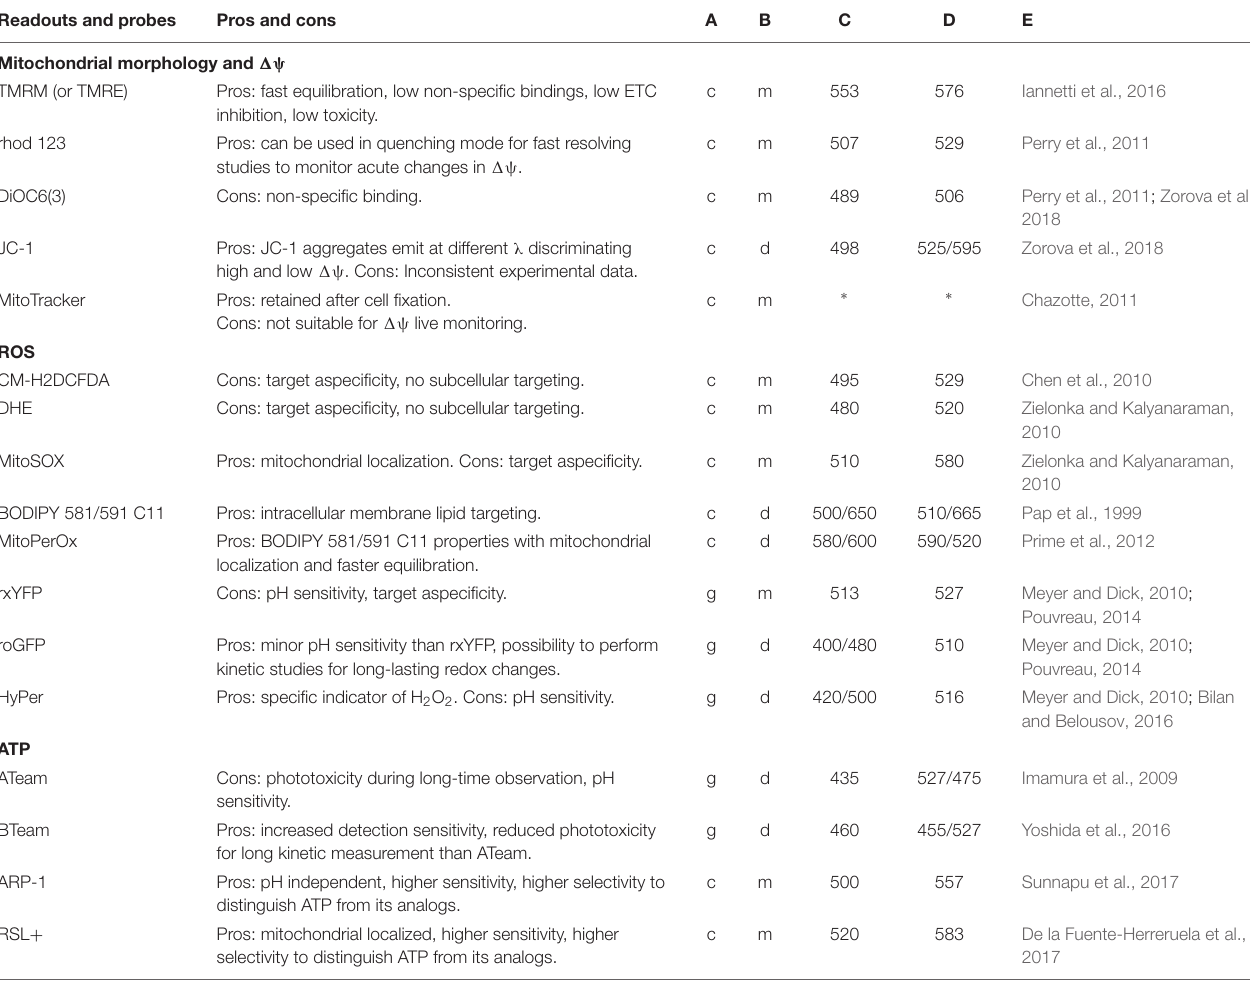
TABLE 1 | Live imaging cell-based mitochondrial readouts and probes. Readouts and probes Pros and